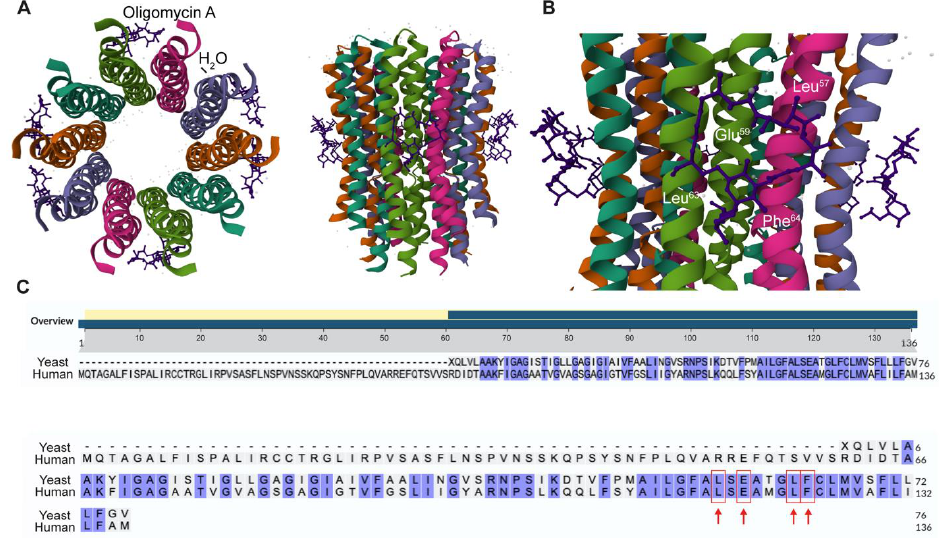
Figure 1. Identification of conserved amino acids involved in Oligomycin A—Csub binding in human sequence. ( A ) High resolution crystal structure (left, top view; right, side view) of Csub binding site in yeast (PDB: 4F4S) and Oligomycin A labeled. Molecules of Oligomycin A are depicted in purple, H 2 O molecules in orange, and Csub chains are colored with the “Chain Id” mode. ( B ) View of the Oligomycin A binding site on yeast Csub. The residues involved in the binding (Leu 57 , Glu 59 , Leu 63 , Phe 64 ) are indicated in white. ( C ) Alignment of yeast Csub protein sequence with the human counterpart. All conserved amino acids are highlighted in blue. Red arrows indicate amino acids topologically equivalent to Leu 117 , Glu 119 , Leu 123 and Phe 124 in human Csub.